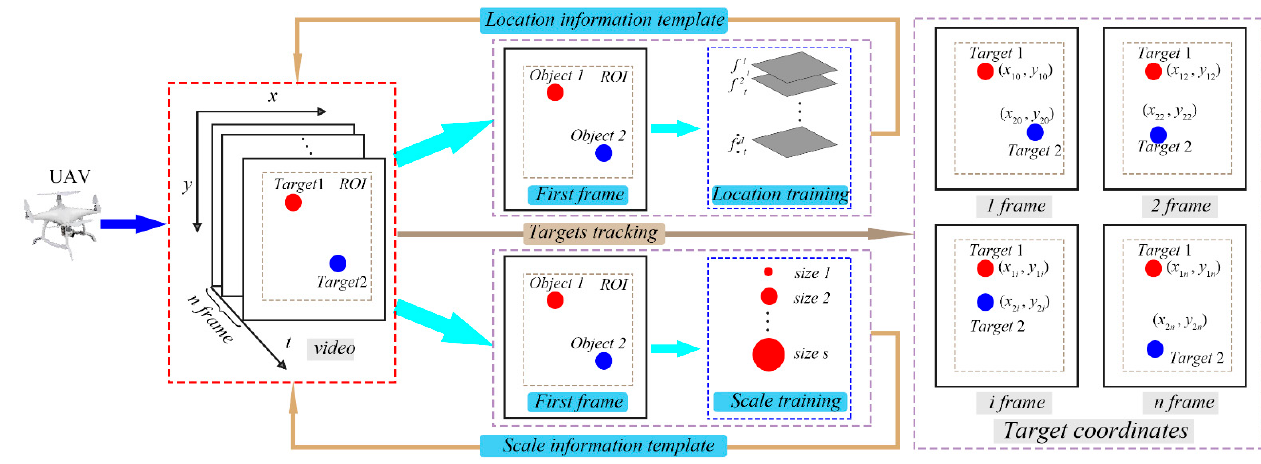
Figure 12. Target-free DSST vision algorithm tracking